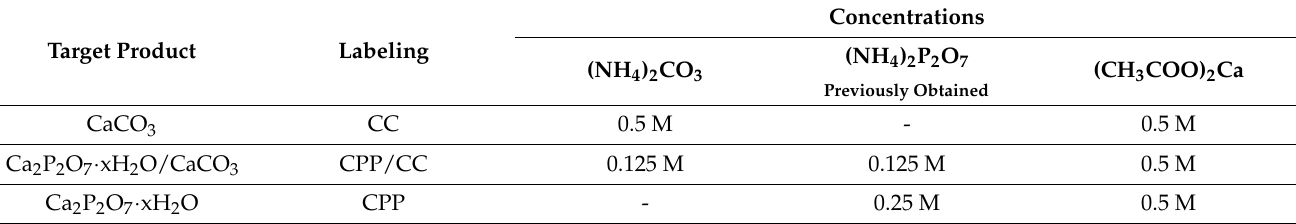
Table 1. Syntheses of powder products in Ca 2 P 2 O 7 -CaCO 3 -H 2 O